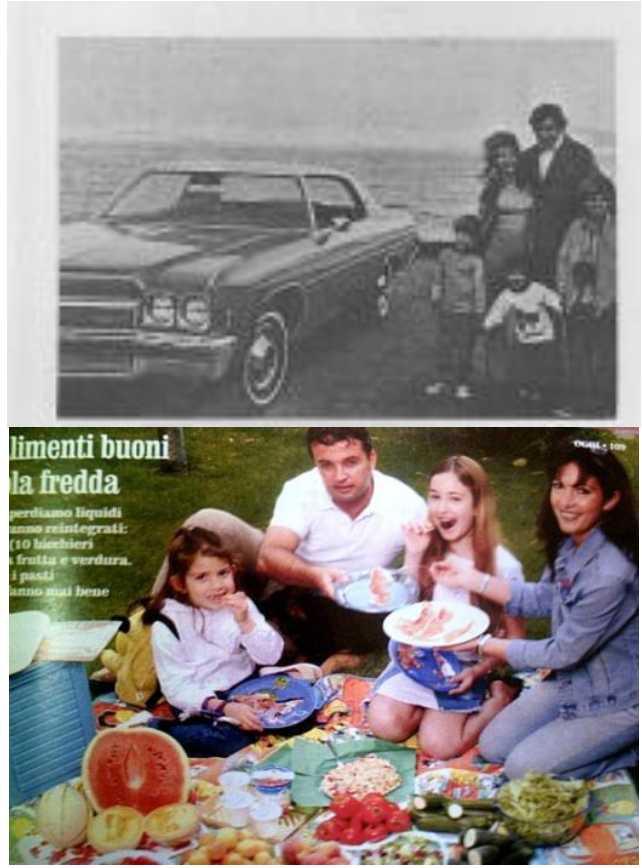
Figure 4. Goffman’s picture and selected picture, Family